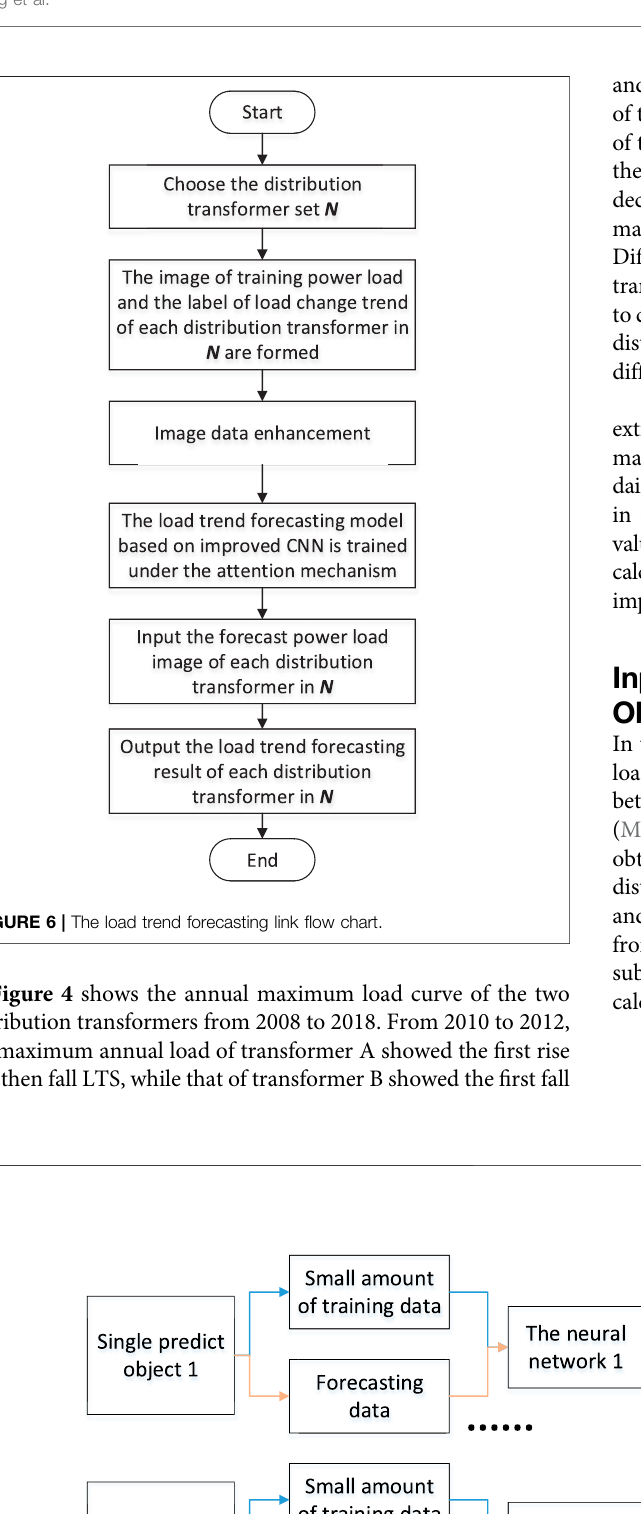
Frontiers in Energy Research |